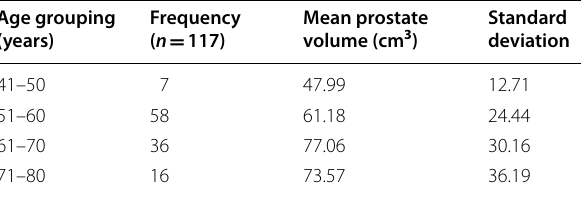
Table 3 Mean prostate volume by age in 117 patients with BPE